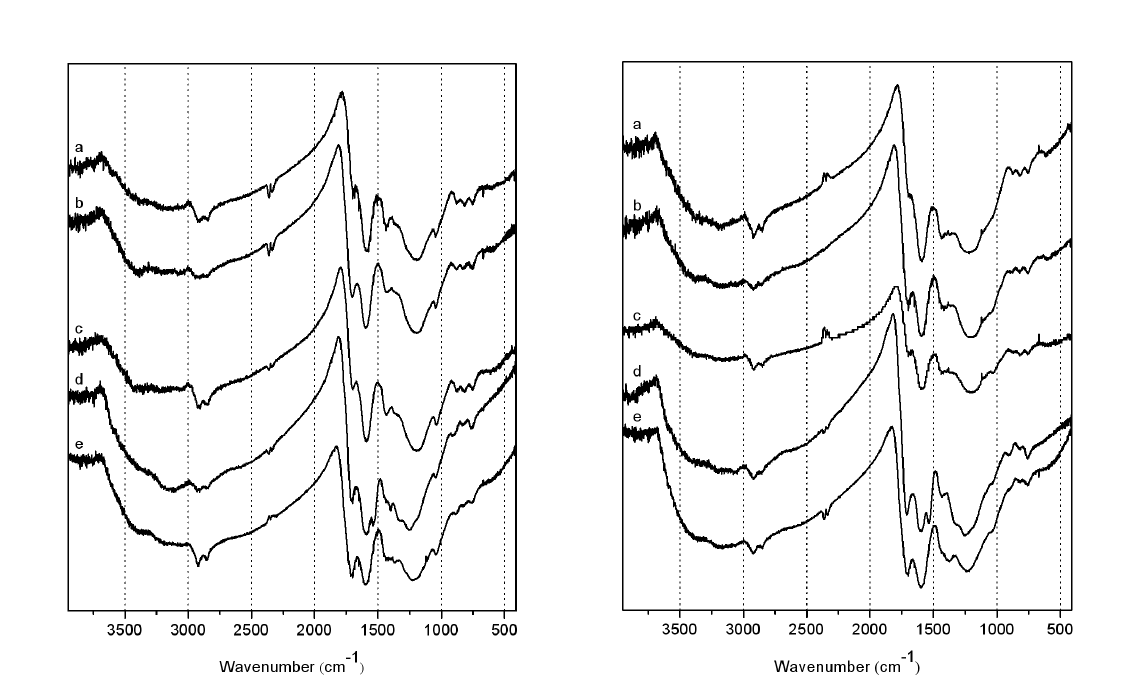
Fig. 1 FTIR spectra of solid products of extraction with THF: (a) dem, (b) O 2 /125, (c) O 2 /Na 2 CO 3 , (d) 5% HNO 3 , (e) PAA.